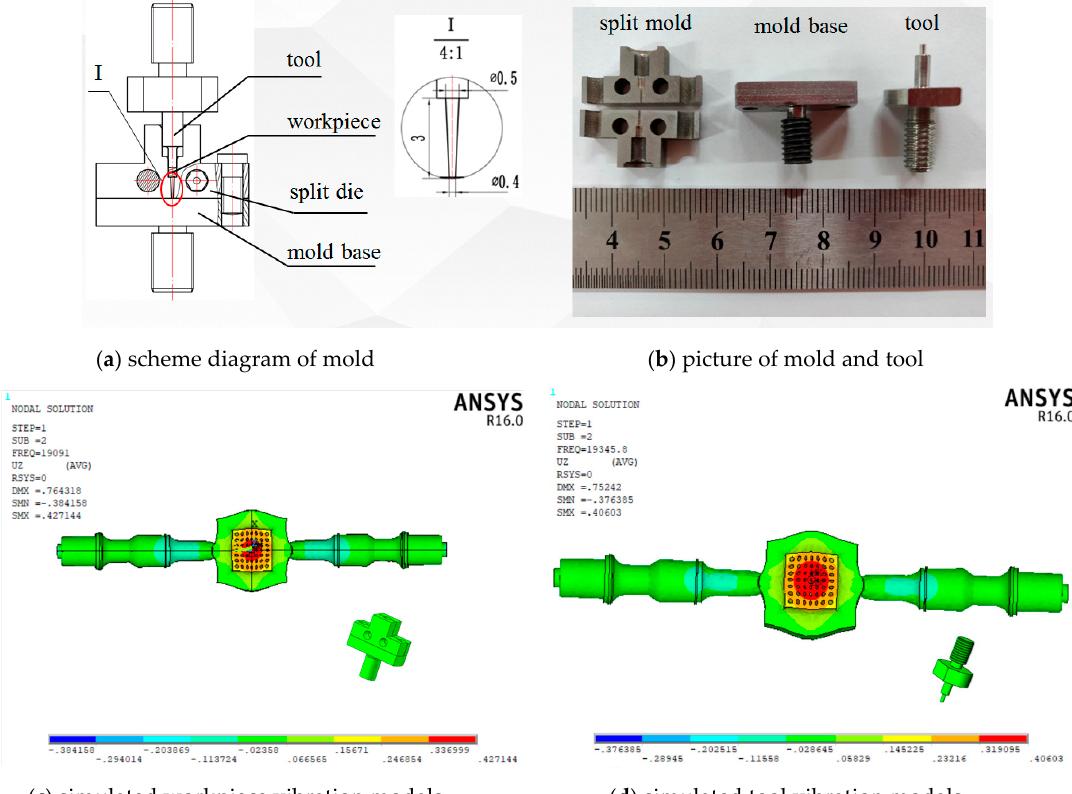
Figure 4. The structure of micro forming molds/tools ( a , b ) and the simulated ultrasonic vibration modals( c , d ).